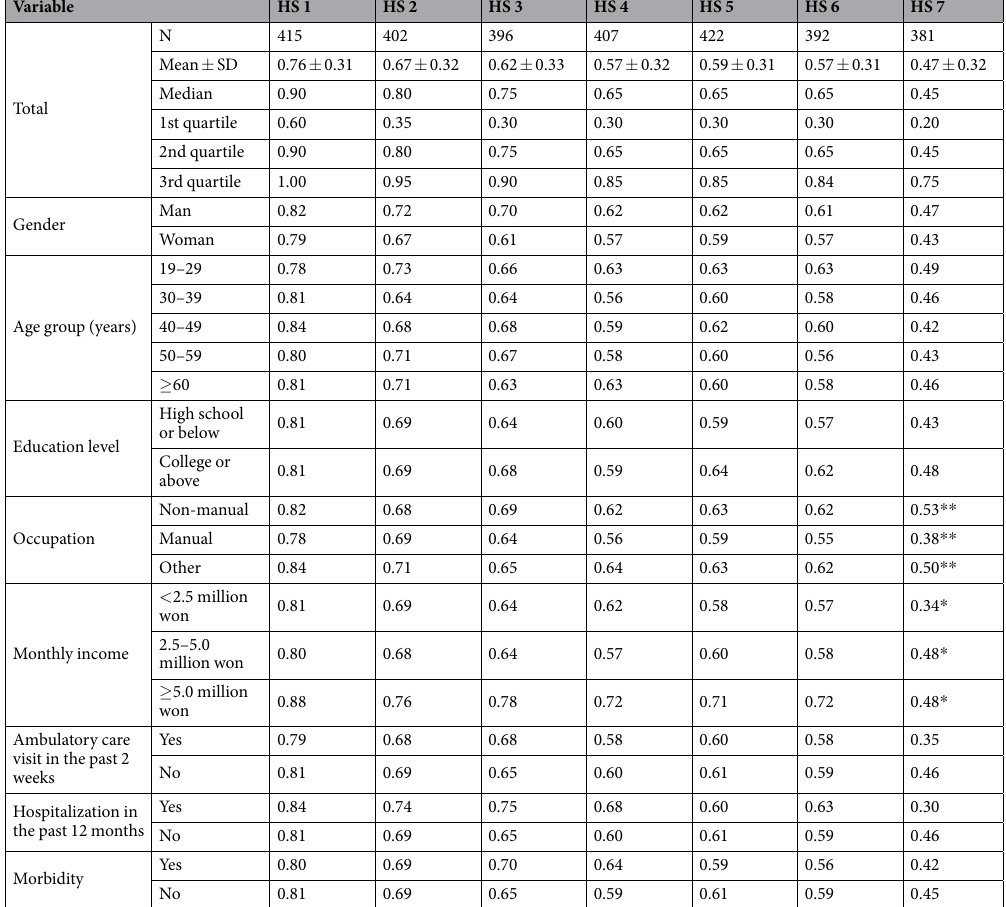
Table 2. Utility weights by health states related to colorectal cancer. * P -value < 0.05, ** P -value < 0.01. HS: health state; SD: standard deviation. HS1: Adenomatous polyps; HS2: Colon cancer requiring colon resection; HS3: Rectal cancer requiring resection of the rectum; HS4: Colon cancer requiring colon resection and systemic chemotherapy; HS5: Rectal cancer requiring resection of the rectum and chemoradiation therapy; HS6: Rectal cancer requiring resection of the rectum, stoma formation, and chemoradiation therapy; HS7: Metastatic colon